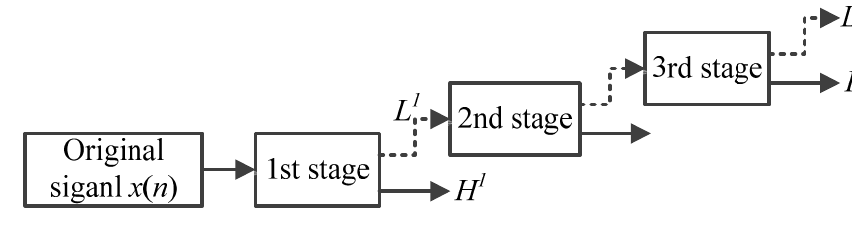
Figure 3. Wavelet transform with level L = 3.